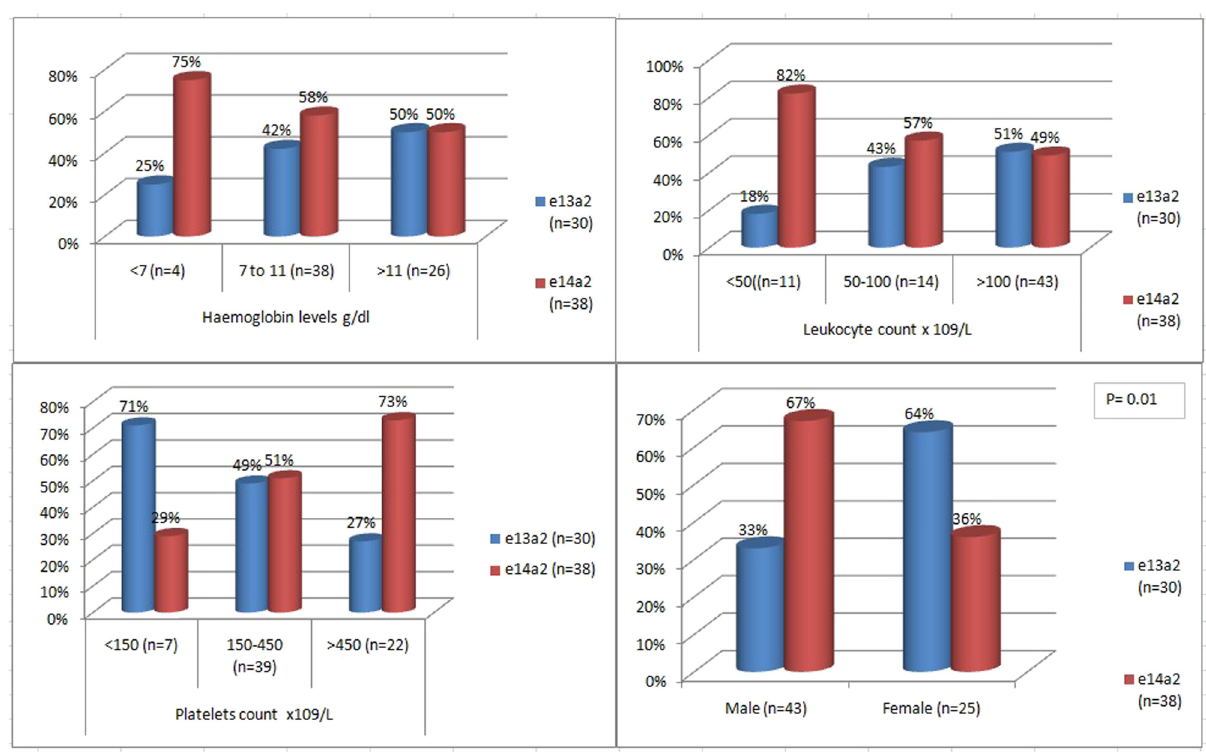
Figure 5: Transcript strati fi ed frequency of CML patients within di ff erent subsets of hematological parameter and gender. Bar chart demonstrates association of these variables with e13a2 and e14a2 transcripts. The types of transcripts are color coded as shown in box. P value of < 0.05 is taken as signi fi